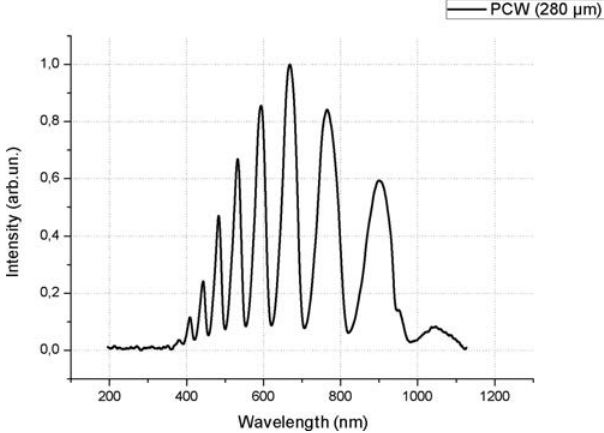
Fig. 3. Transmission spectrum of the chirped photonic crystal waveguide (hollow core diameter is 280 (cid:1)